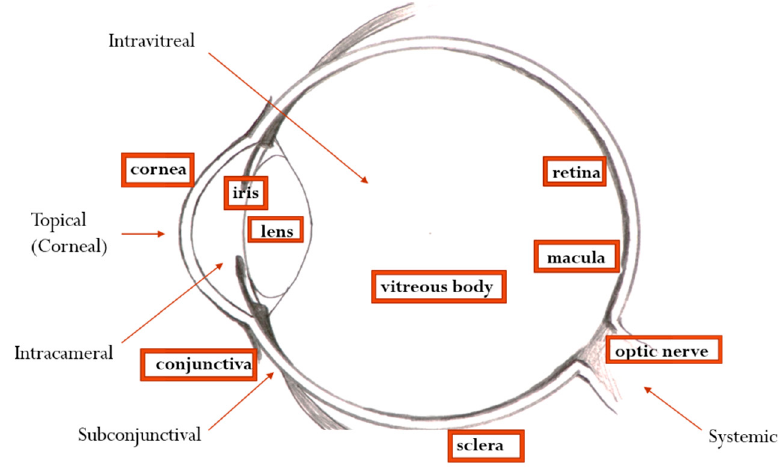
Figure 1. Main routes of ophthalmic drug administration.